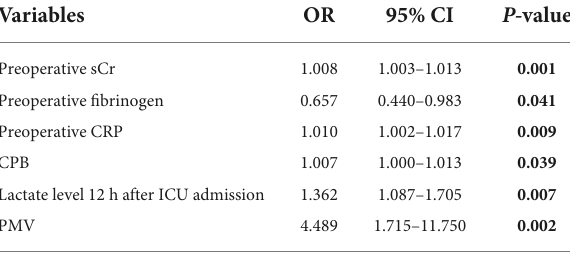
TABLE 5 Multivariate analysis of risk factors for postoperative CRRT.